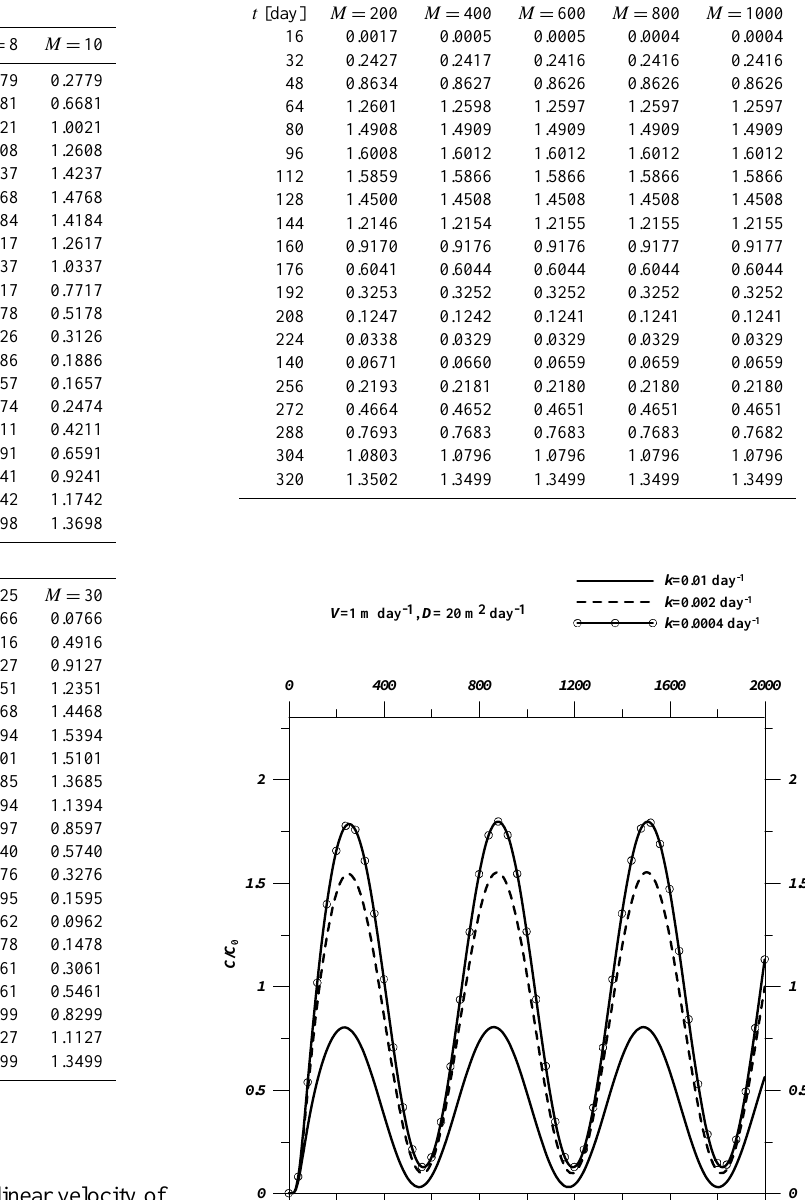
cause the spreading effect by dispersion processes and con- centration reduction effect by decay process is enhanced for long solute resident time under low V